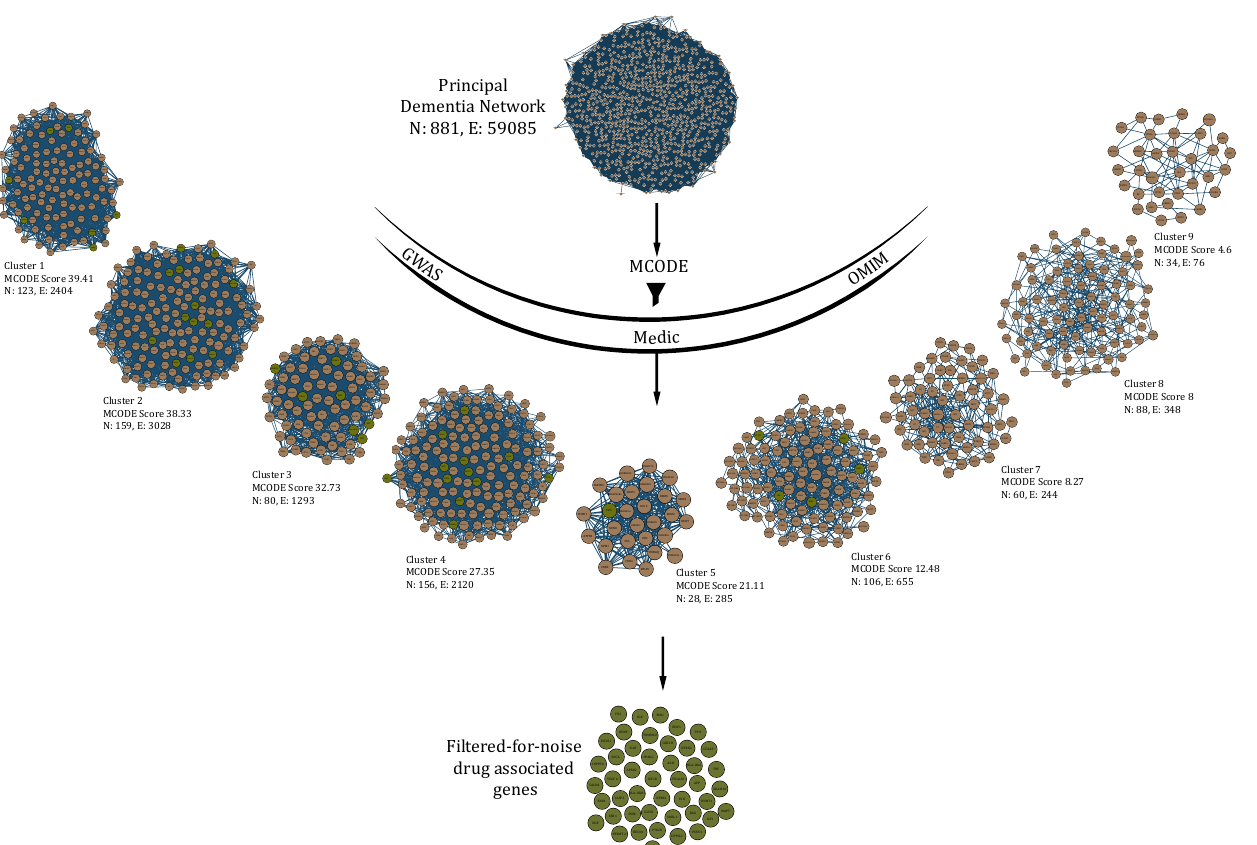
Figure 3. Drug-associated genes obtained from various sources (GWAS, Medic, OMIM) were “filtered for noise” in protein complexes obtained from the principal dementia network (PDN) using stringent parameters in MCODE algorithm. Only those complexes with a score greater than 10 were considered for this